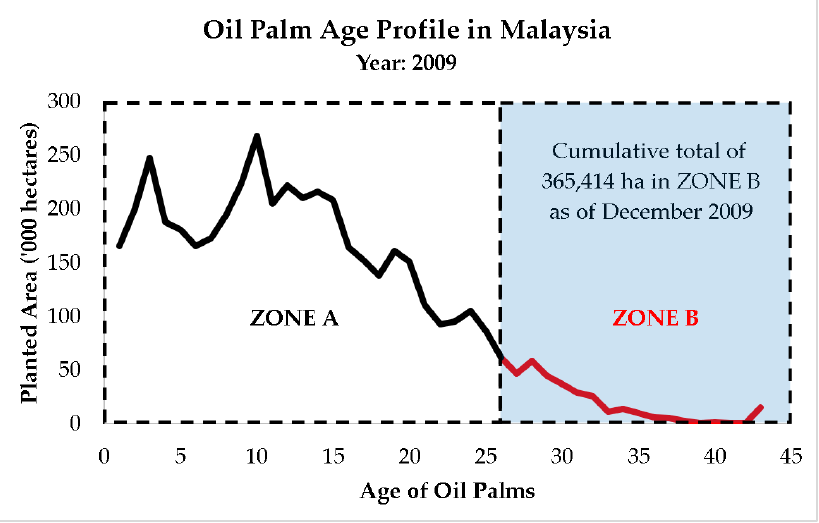
Figure 3. Age profile of oil palm planted area in 2009 [10]. Note: there was no updated age profile reported by government agencies after 2010.